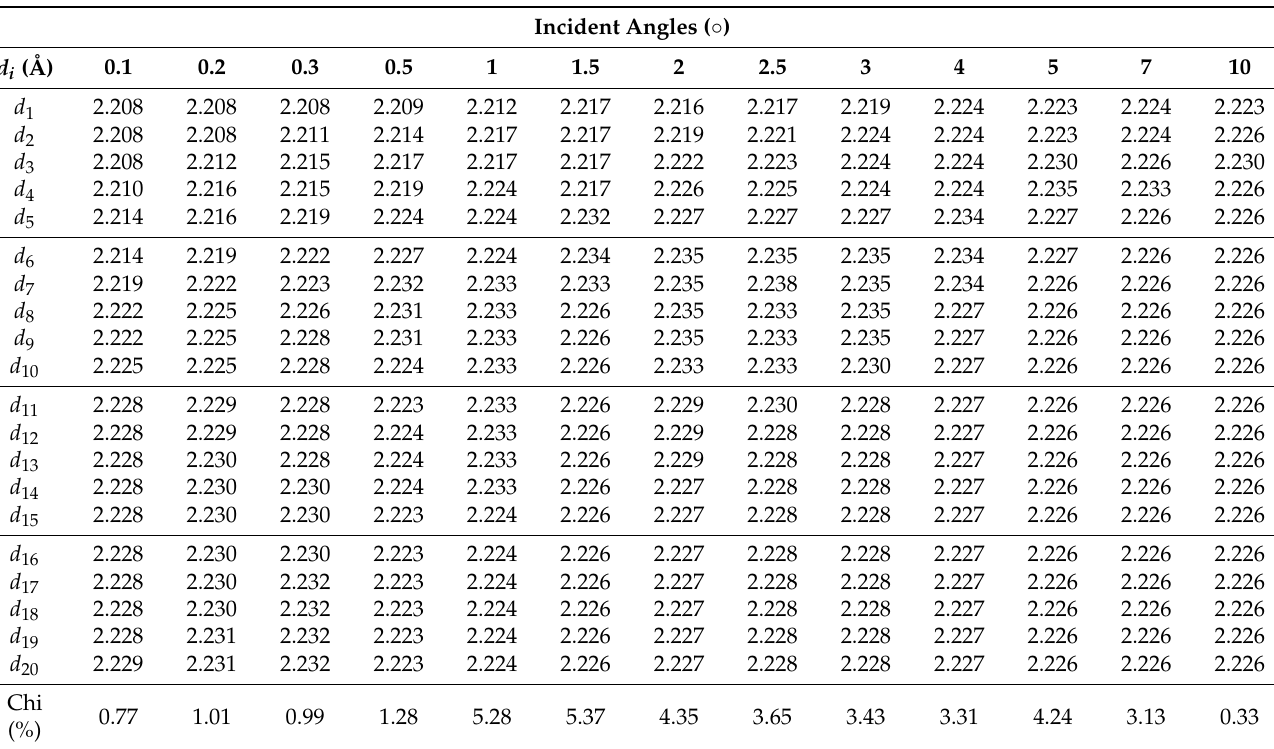
Table 1. Fitted (110) interplaner spacing d i of a 2 × 10 21 ions/m 2 irradiated W at different incident angles. Chi represents the fitting error. Incident Angles ( ◦